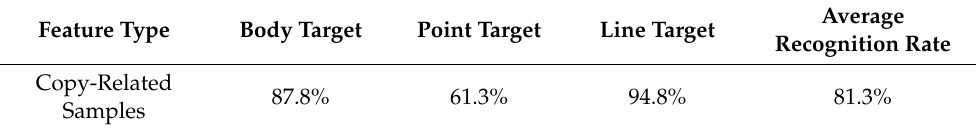
Table 3. Comparison of target recognition rate using different samples.